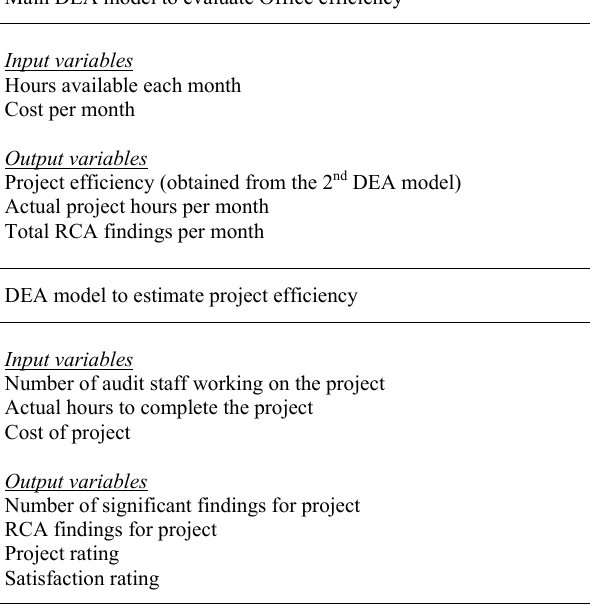
Table 1: DEA input and output